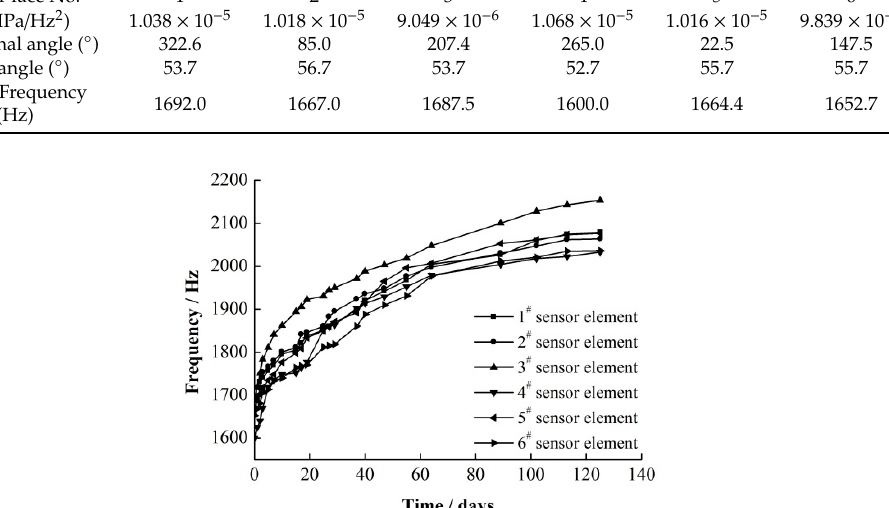
Figure 17. Frequency change with time of transducers buried in the PDS No. 11 coal mine.